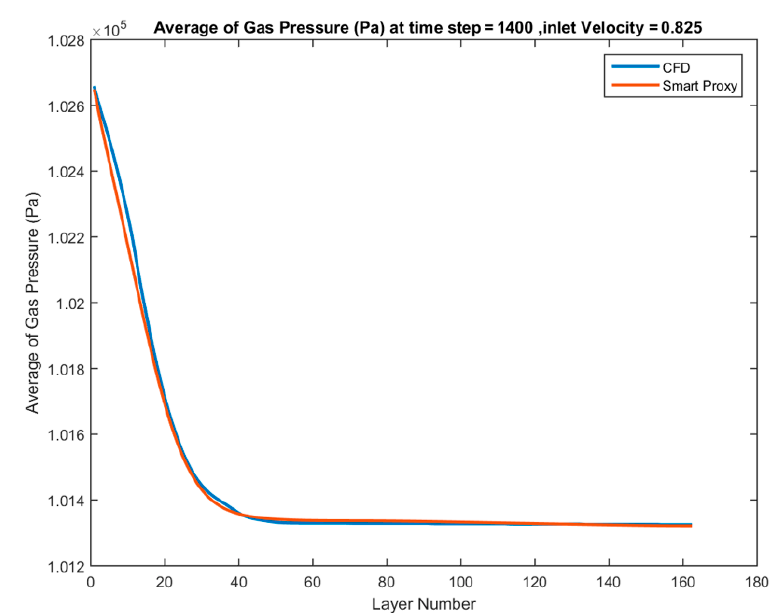
Figure 41. Spatially averaged CFD and smart proxy results for gas pressure (Pa) at time step = 1400 = 0.825 m / s. for blind test condition of V in = 0.825 m/s. blind test condition of V in